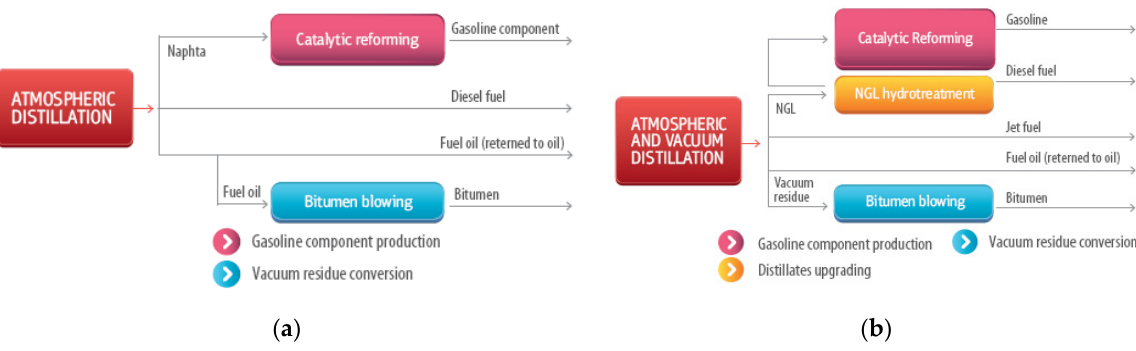
Figure 3. Schematic diagrams of mini-refineries in Urai ( a ) and Kogalym ( b ).